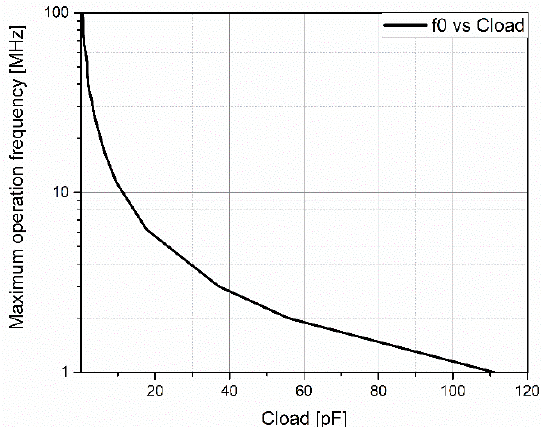
Figure 4. Maximum transmitter operating frequency as a function of load capacitance (simulation results).